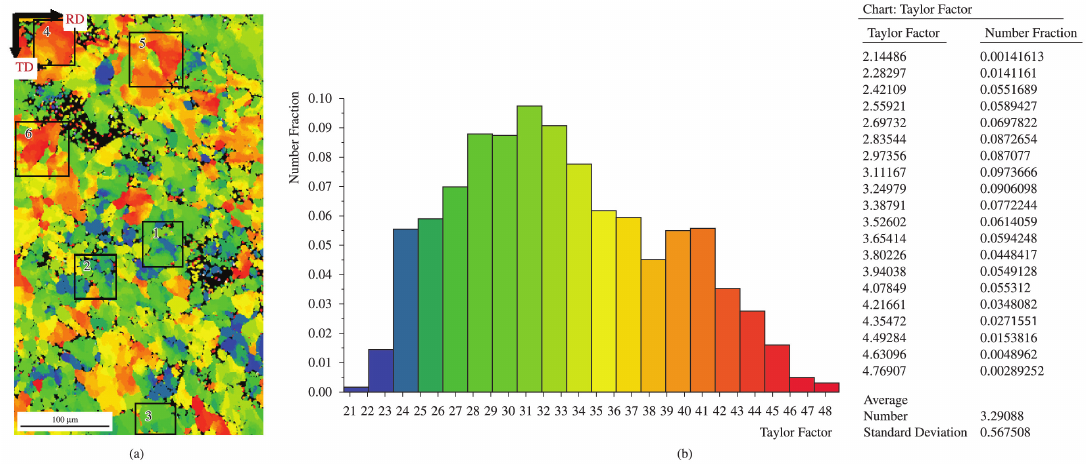
Figure 18. Mapping of Taylor factor: a) scan region; b) histogram of number